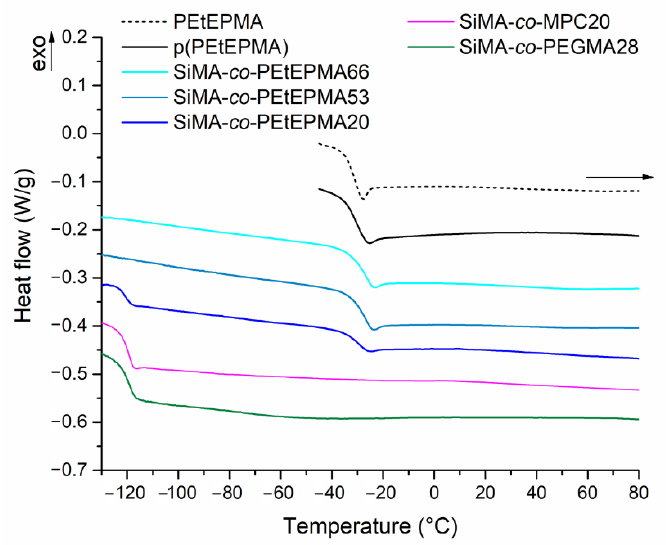
Figure 2. DSC second heating curves of the amphiphilic